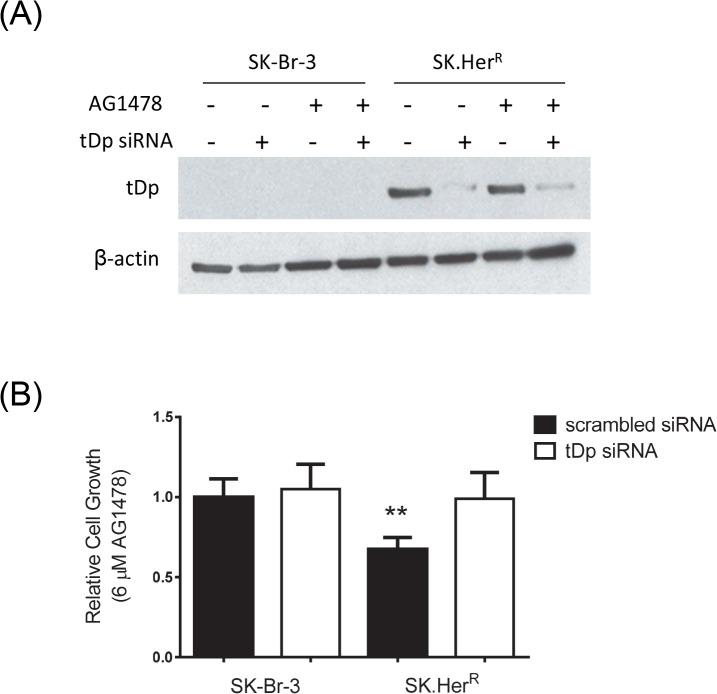
t-Darpp is responsible for increased EGFR sensitivity in SK.HerR cells.SK-Br-3 and SK.HerR cells were transfected with scrambled (-) or tDp siRNA (+). 24 hours later, cells were treated with DMSO or AG1478 for an additional 24 hours. (A) Western analysis to confirm siRNA knockdown. (B) SRB cell proliferation assay to determine relative sensitivity to AG1478. Shown are the averages (± S.D.) of four experiments, with normalization to DMSO-treated controls in all cases. **, p<0.01.